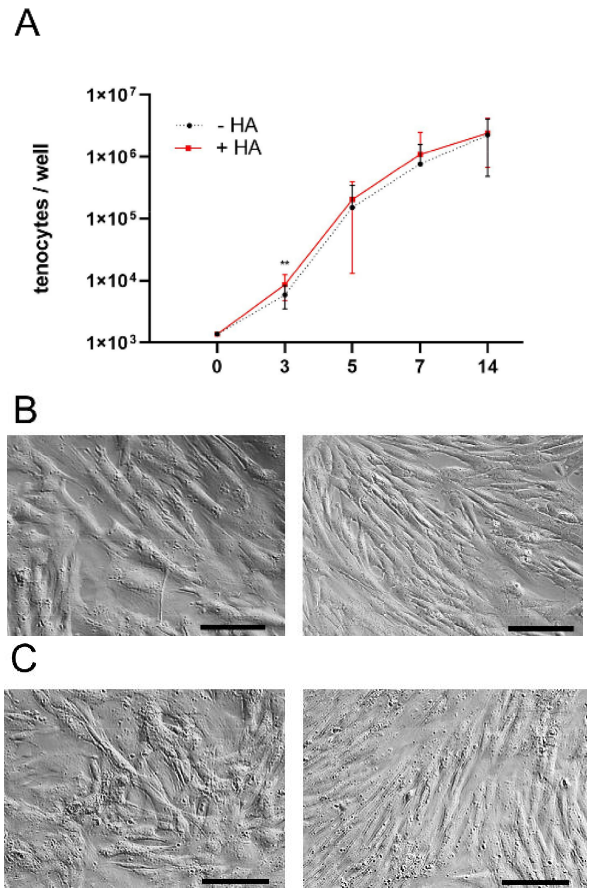
Figure 1. Proliferation of rabbit Achilles tenocytes in vitro (n = 3 rabbits) with or without HA ( A ). Values denote means and error bars stand for standard deviations. Tenocytes after 2 weeks of culture without ( B ) or with HA supplementation ( C ). Scale bar: 100 µm. p < 0.01 (**).